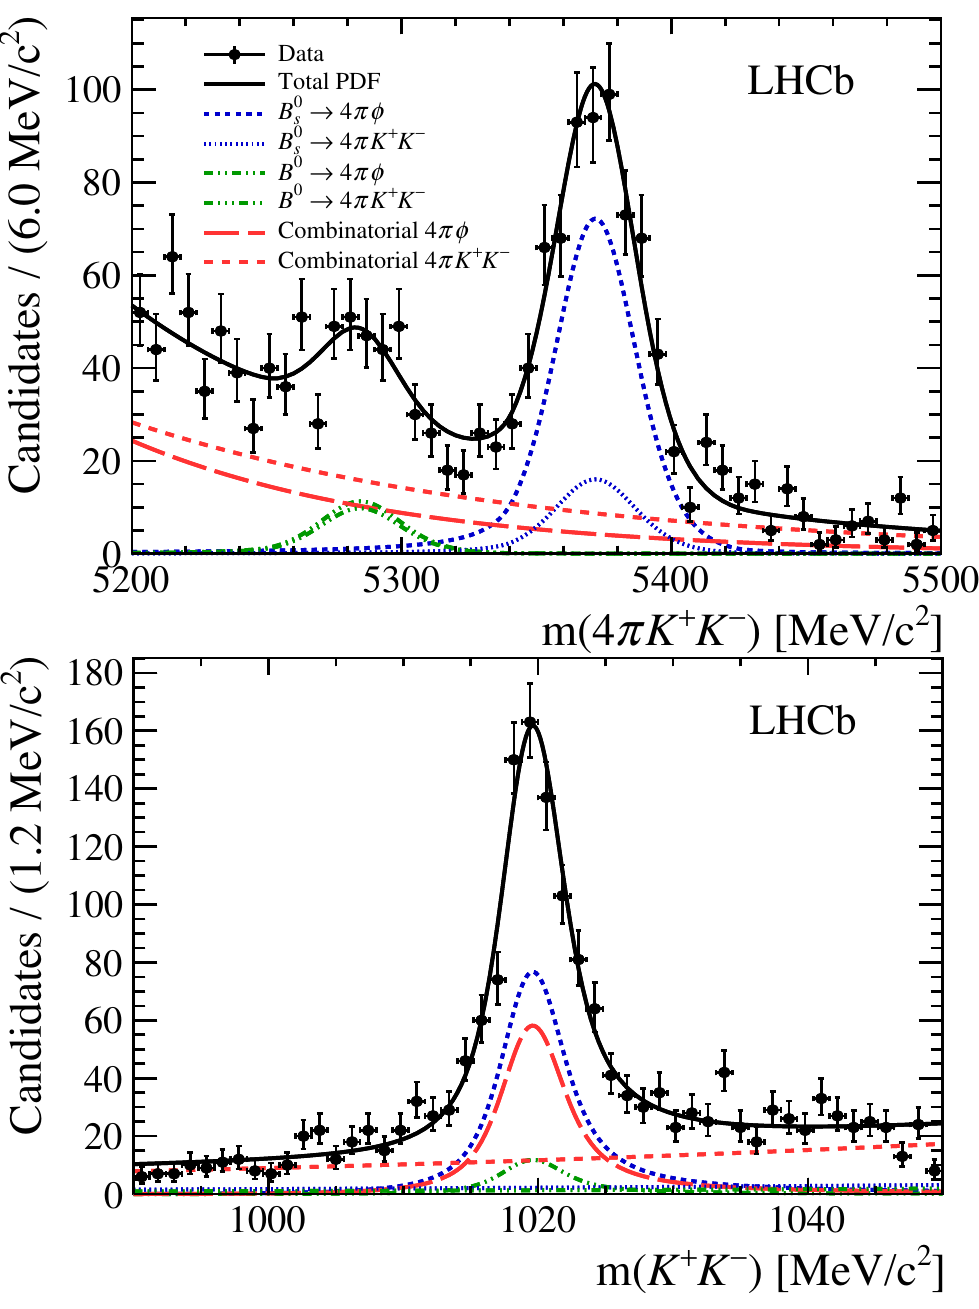
Figure 8 . Distribution of the 4 (cid:25)K + K (cid:0) (top) and K + K (cid:0) (bottom) invariant masses. Points with error bars show the data. The solid black curve is the projection of the total (cid:12)t result. The ! 4 (cid:25)K + K (cid:0) contributions, short-dashed and dotted blue curves show the B 0 ! 4 (cid:25)(cid:30) and B 0 s s respectively. The long-dashed and medium-dashed red curves show the contributions of the com- binatorial background with prompt (cid:30) and NR K + K (cid:0) , respectively. The dashed-double-dotted and dashed-triple-dotted green curves show the B 0 ! 4 (cid:25)(cid:30) and B 0 ! 4 (cid:25)K + K (cid:0) contributions, respectively.